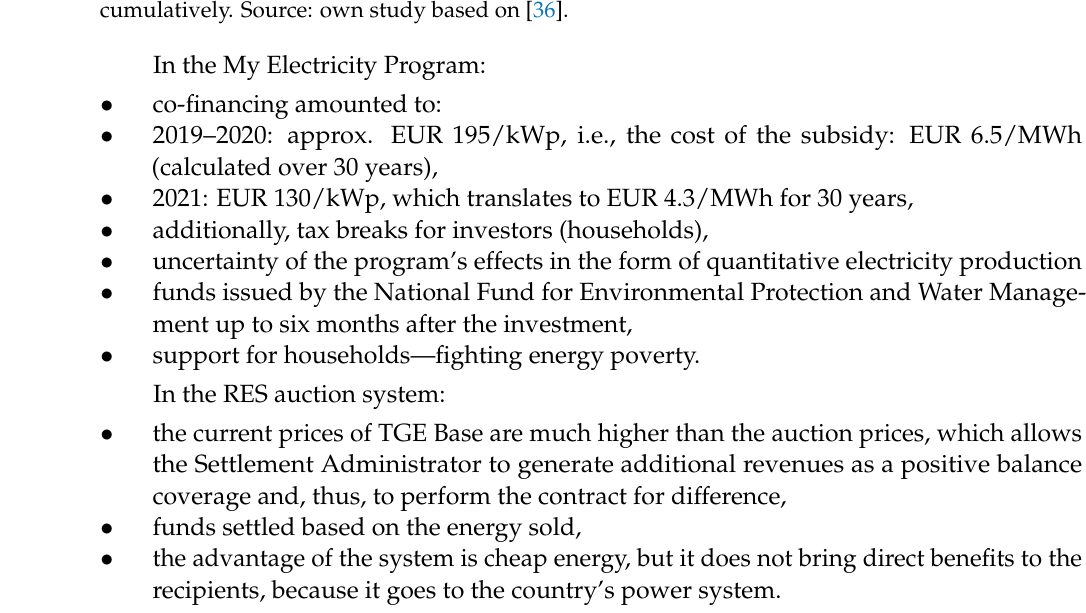
Figure 11. Comparison of the My Electricity Program and the RES auction system—installed capacity cumulatively. Source: own study based on [36].